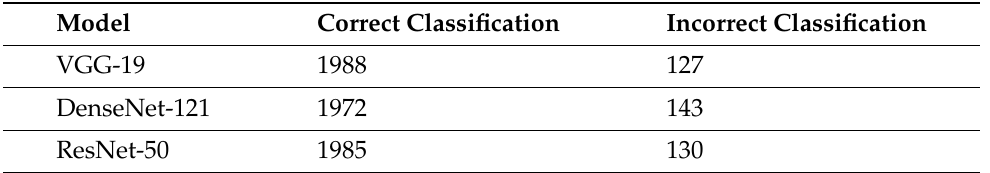
Figure 10. VGG-19 model was trained for 100 epochs. The plot on the right depicts the train vs. validation accuracy. Table 3. A summary of total images classified correctly and incorrectly by VGG-19, DenseNet-121, and ResNet-50 using a total test dataset of 2115 images. Amongst the three models, VGG-19 demon- strated high accuracy of XCR image classification with only 127